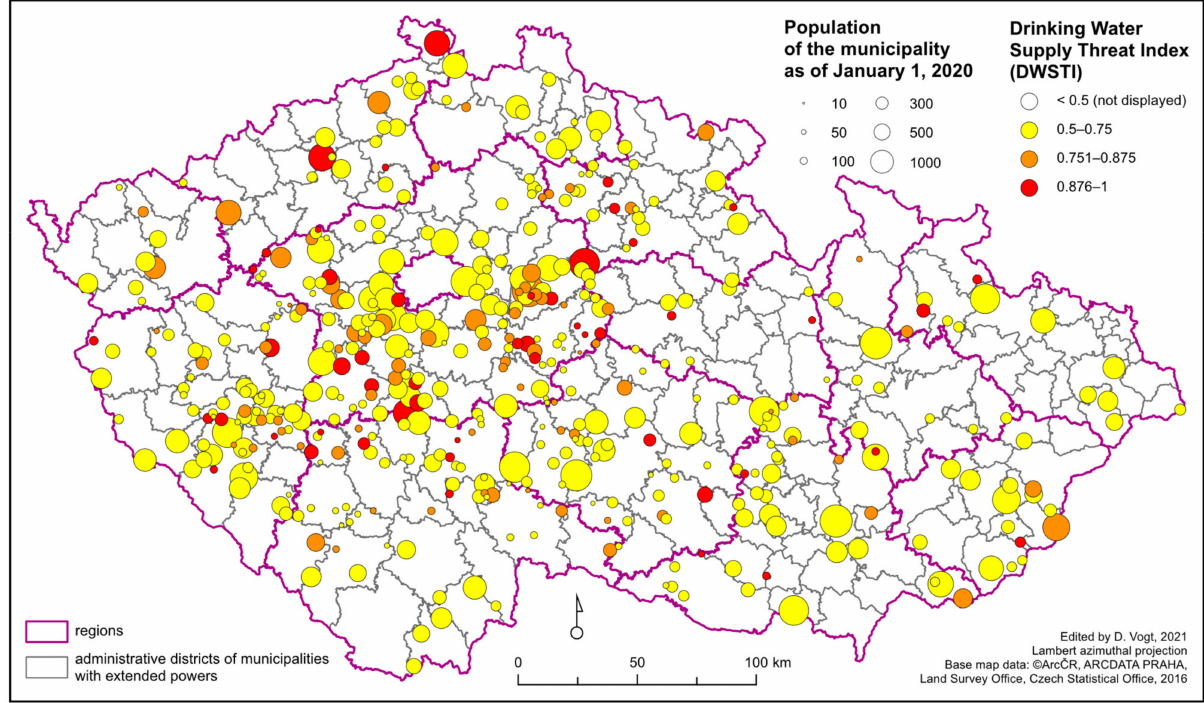
Figure 7. Small municipalities in the Czech Republic with a value of DWSTI ≥ 0.5 (n = 468) evaluated according to DWSTI and population size. Source: own processing based on questionnaire survey and data